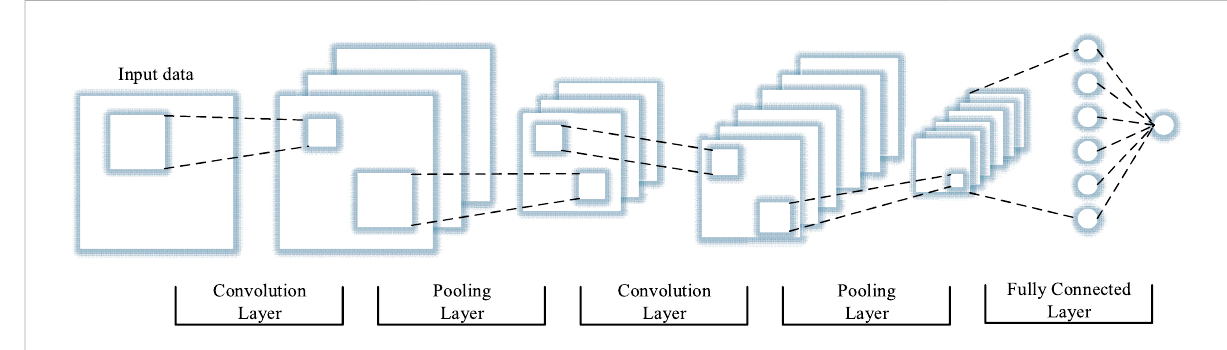
FIGURE 2 Typical structure of the convolutional neural network.